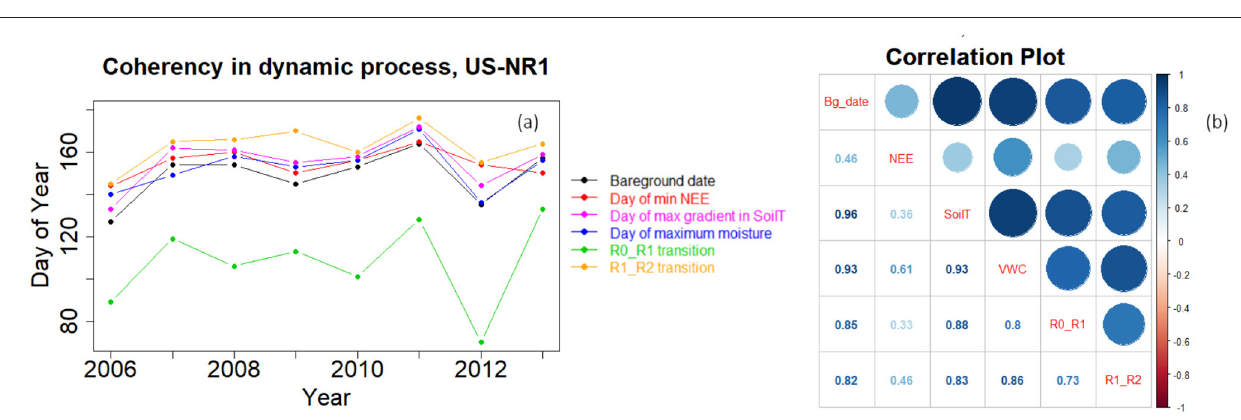
FIGURE 8 | Coherence between hydrological indices, R0–R1, and R1–R2 transitions at US-NR1: (A) presents the annual series of bareground date (Bg_date), day of minimum net ecosystem exchange (NEE), day of maximum gradient in soil temperature (SoilT), day of maximum soil moisture (VWC), R0_R1 transition, and R1_R2 transition; (B) depicts the correlation plot among these